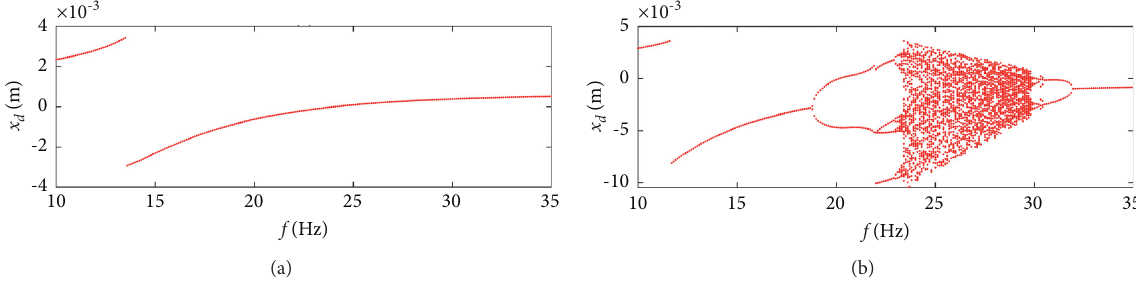
Figure 12: Bifurcation diagrams with excitation frequency f as bifurcation parameter ( k � 2mm. (b) A 0